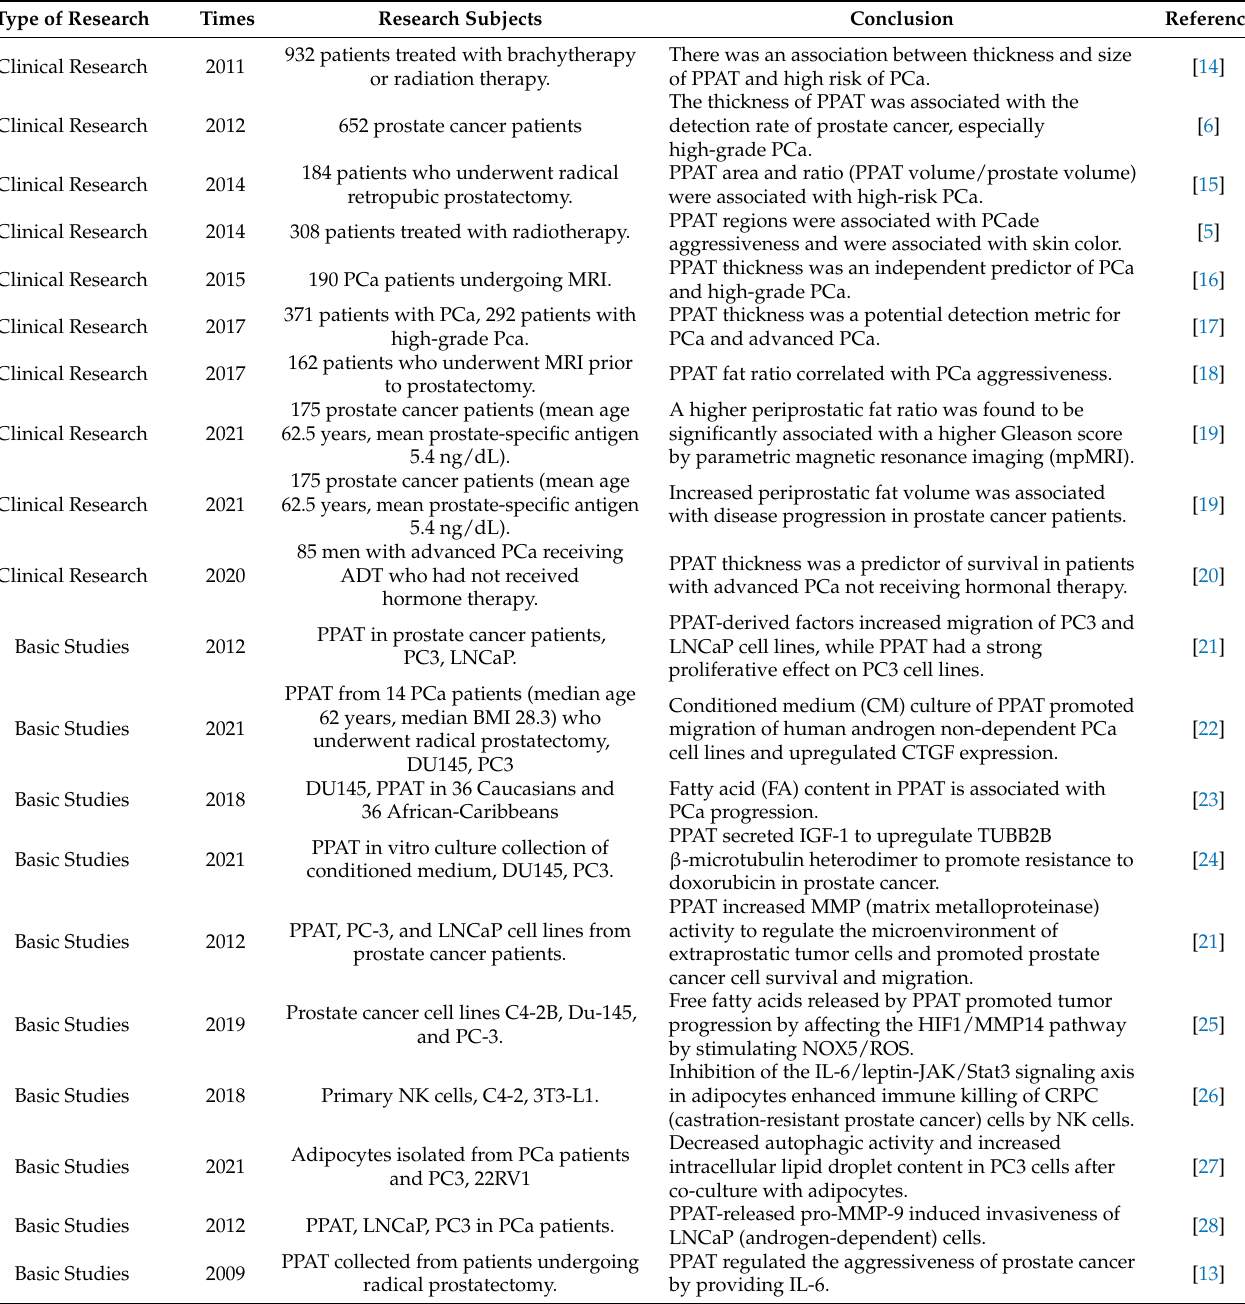
Table 1. Cross-talk between PPAT and